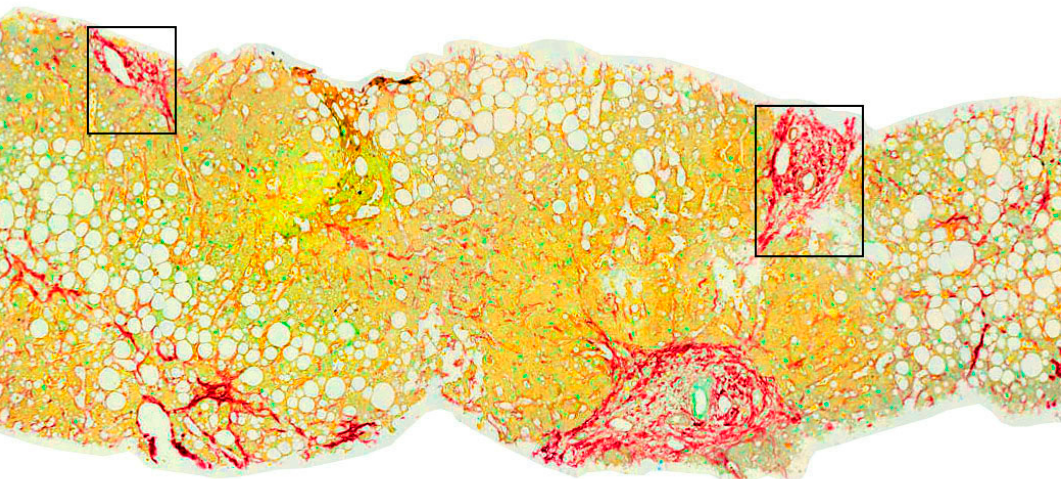
Figure 5. Paraffin-embedded sample and stained with Sirius red dye. The bounding boxes indicate areas of high collagen accumulation, where parenchymal nodules are surrounded by fibrous tissue, meeting the diagnostic criteria of cirrhosis.